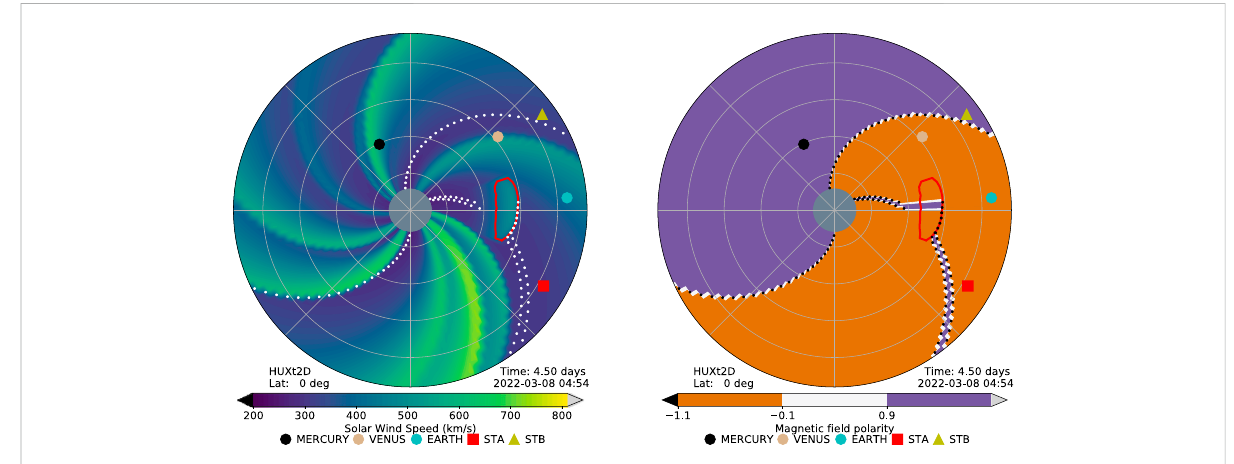
FIGURE 10 Snapshots of the HUXt solar wind speed (left) and magnetic fi eld polarity (right) for Carrington rotation 2254. The boundary of a cone CME is shown in red. Black and white lines show heliospheric current sheet positions of positive to negative radial fi eld transitions (with increasing radial distance) and negative to positive,